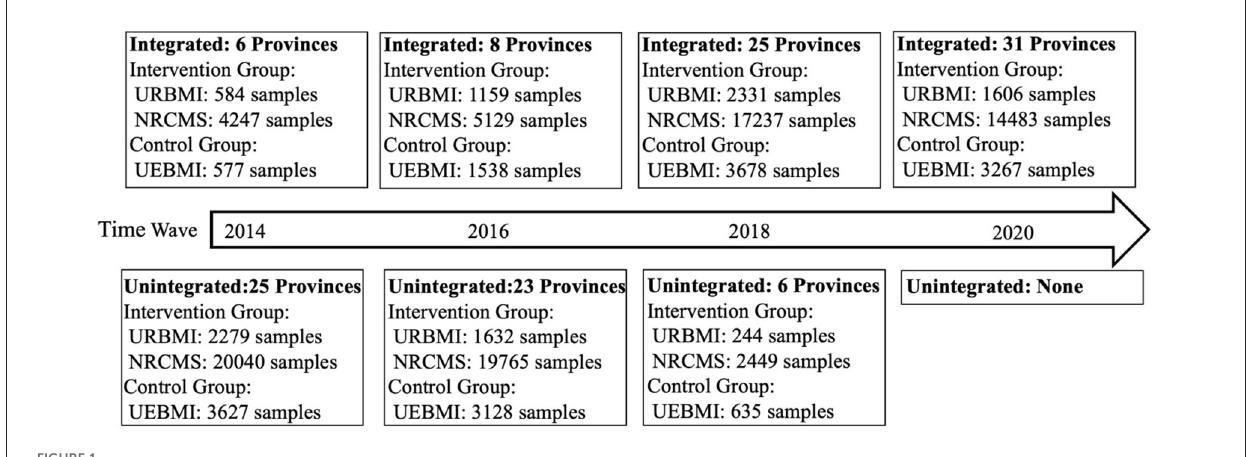
FIGURE1 Intervention and control groups and waves.